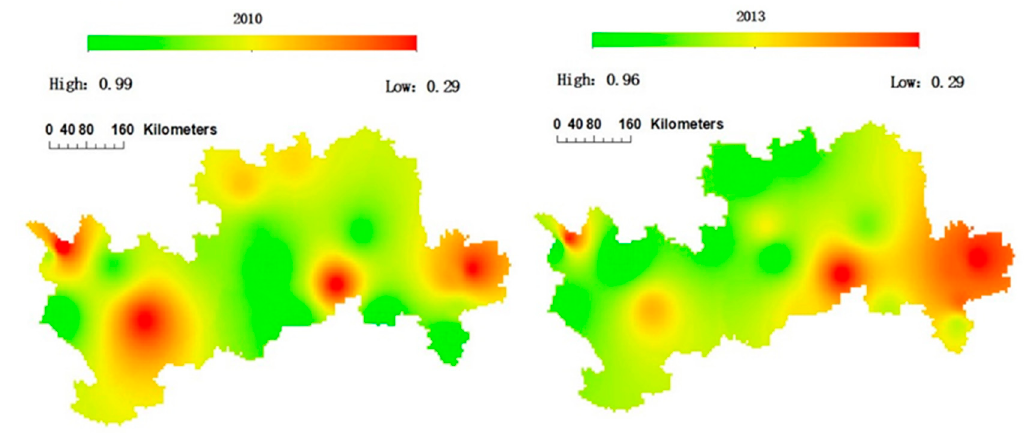
Figure 6. Spatial evolution of the water suitability of apple trees in the study area from 1990 to 2013.